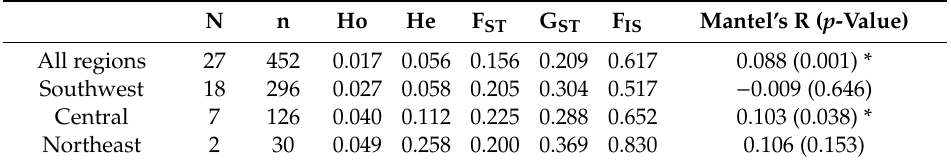
Table 3. Measures of genetic diversity (observed heterozygosity (Ho) and gene diversity (He)) and fixation indices, calculated to determine the proportion of genetic variation contained in sites, relative to the total observed variation (F ST and G ST ) and the proportion of the overall variation contained in an individual (F IS ). Analyses were performed on the entire dataset ( n = 452). N = number of sites, n = number of samples. Statistics based on assemblies of each region were also calculated. Mantel’s R